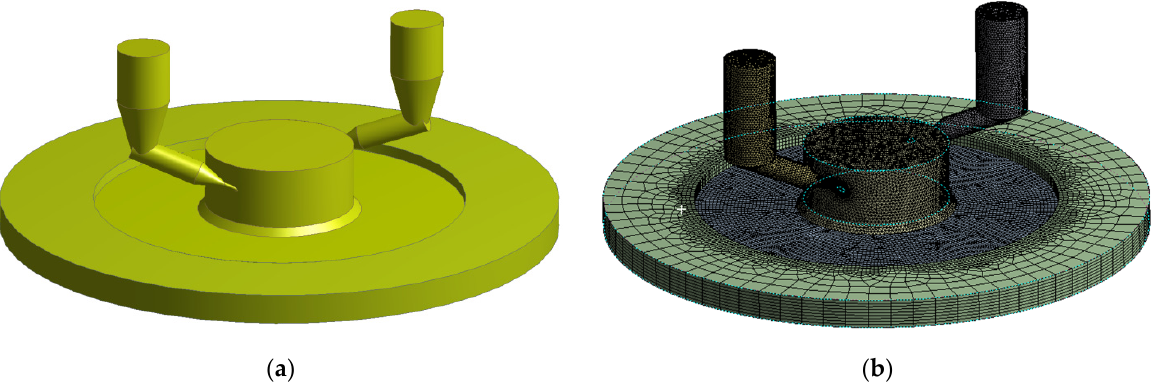
Table 3. Values of relaxation factors in CFD solution controls.